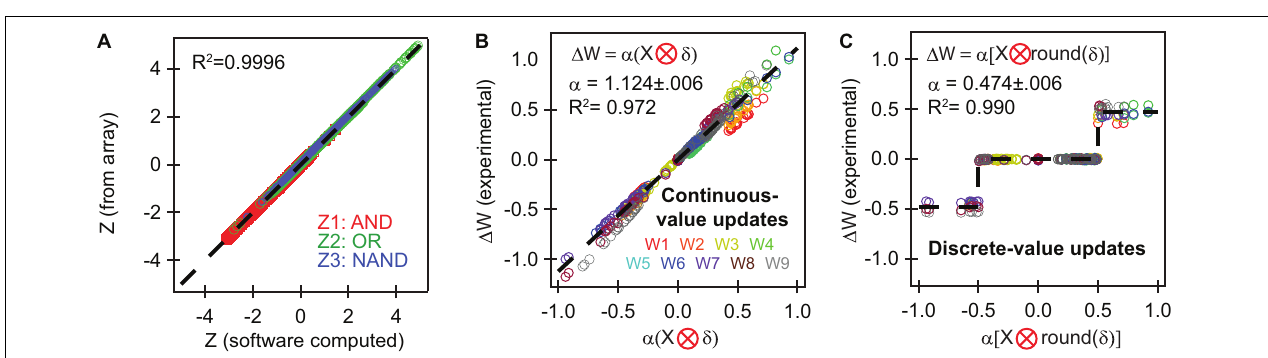
FIGURE 4 | Simulated training behavior compared to the experimental behavior. (A) (left) Simulated weight evolution using the switching properties measured in Figures 1C,D . The results are essentially identical to the experimental results in Figure 3A . (right) A plot of the experimental vs. simulated weights show an R 2 = 0.997, demonstrating that the simulations can fully replicate in-situ experimental training procedures. The weights across all epochs are plotted. (B) Ideal numerical weight evolution for the logic gates assuming perfectly linear and symmetric devices at floating point precision. There exist some deviations at higher and lower weights as a result of nonlinear and asymmetric switching behavior at the extremes of dynamic range in experimental ECRAM devices. (C,D) Comparison of simulated, ideal, and experimental results using the discrete-value rather than continuous-value weight updates. These show more deviations than (A,B) because slight variations in weights may result in an extra, relatively large weight update in the experimental results. All colors have the same meaning as in Figure 1C .